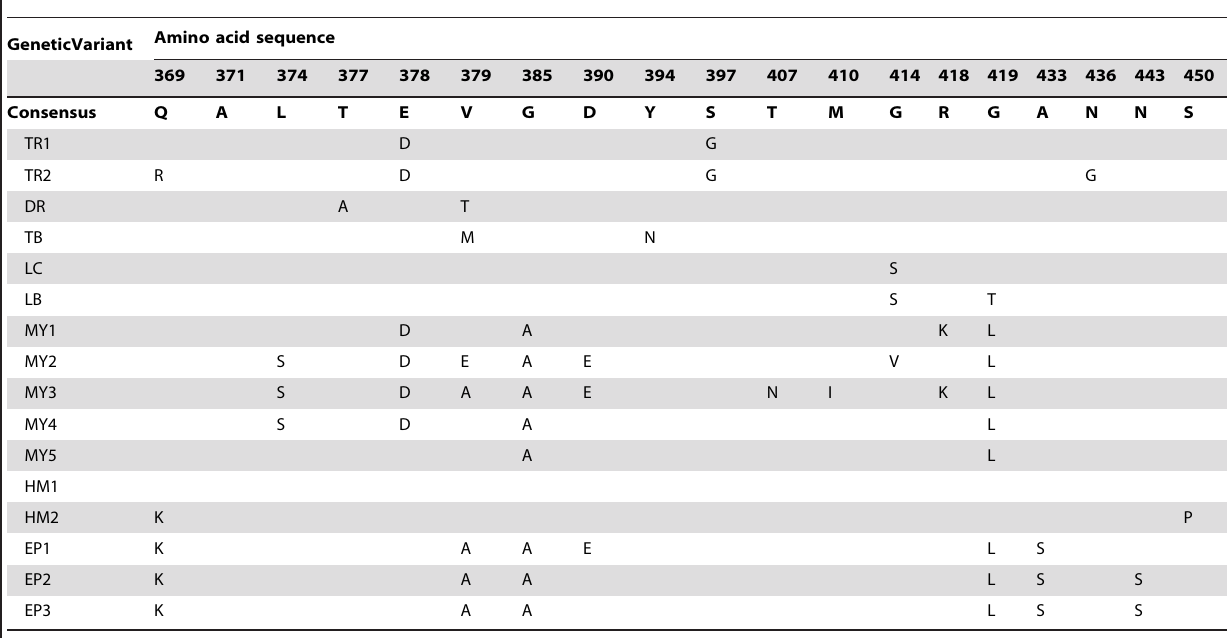
Table 3. Consensus amino acid sequences of bat rabies viruses from Argentina.